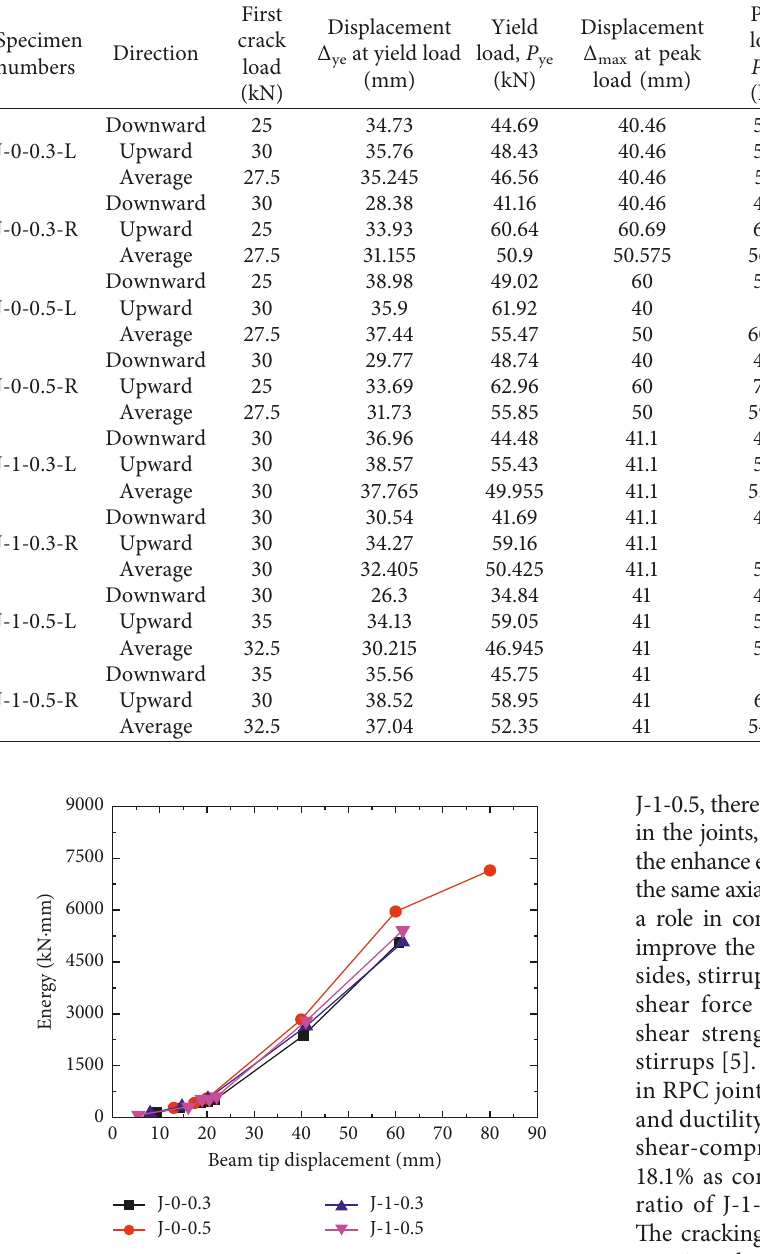
Table 5: Main feature points’ test results and displacement ductility factor.